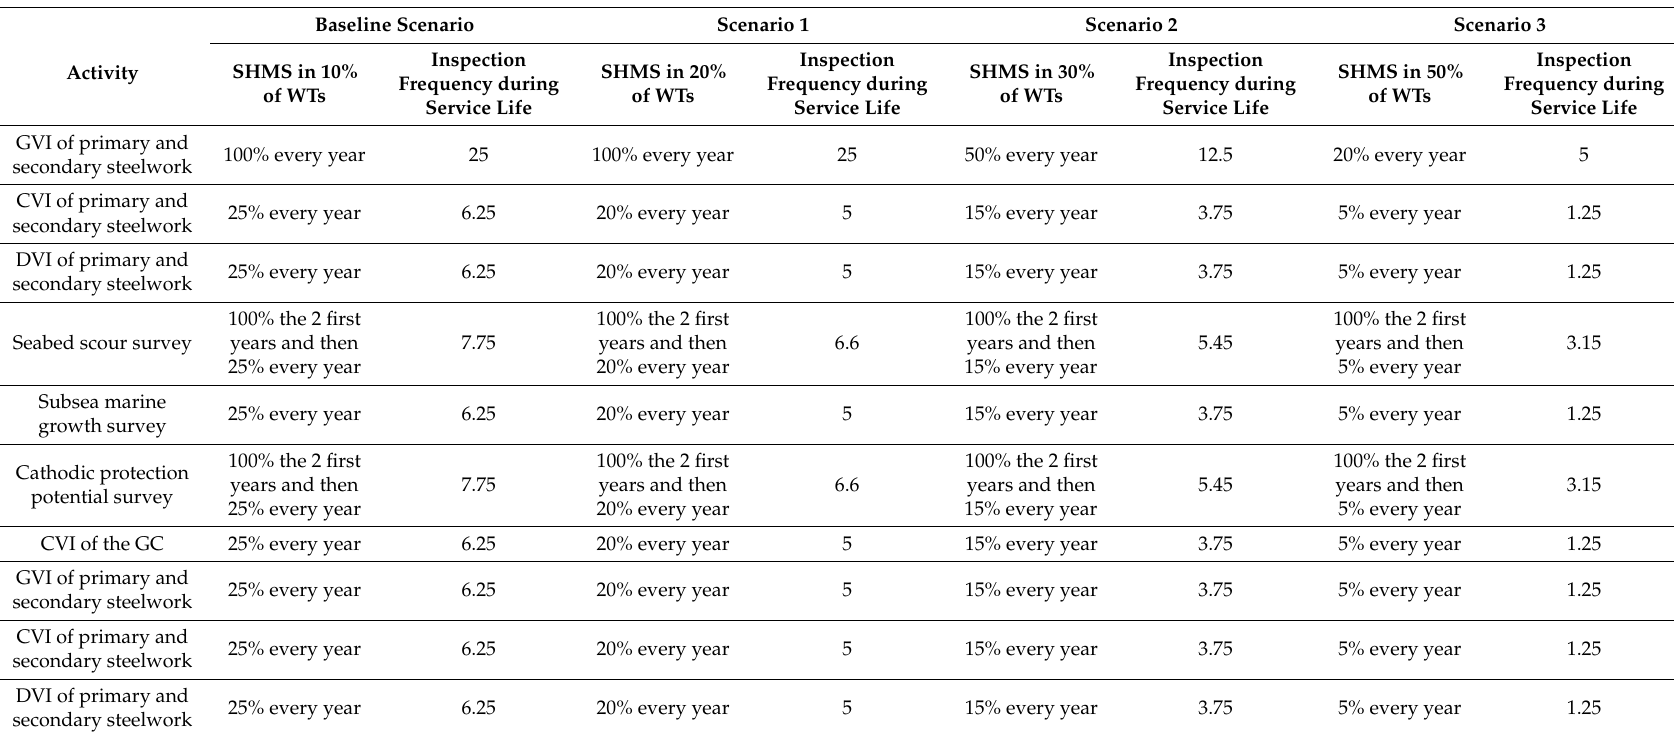
Table 7. Scenarios of SHM